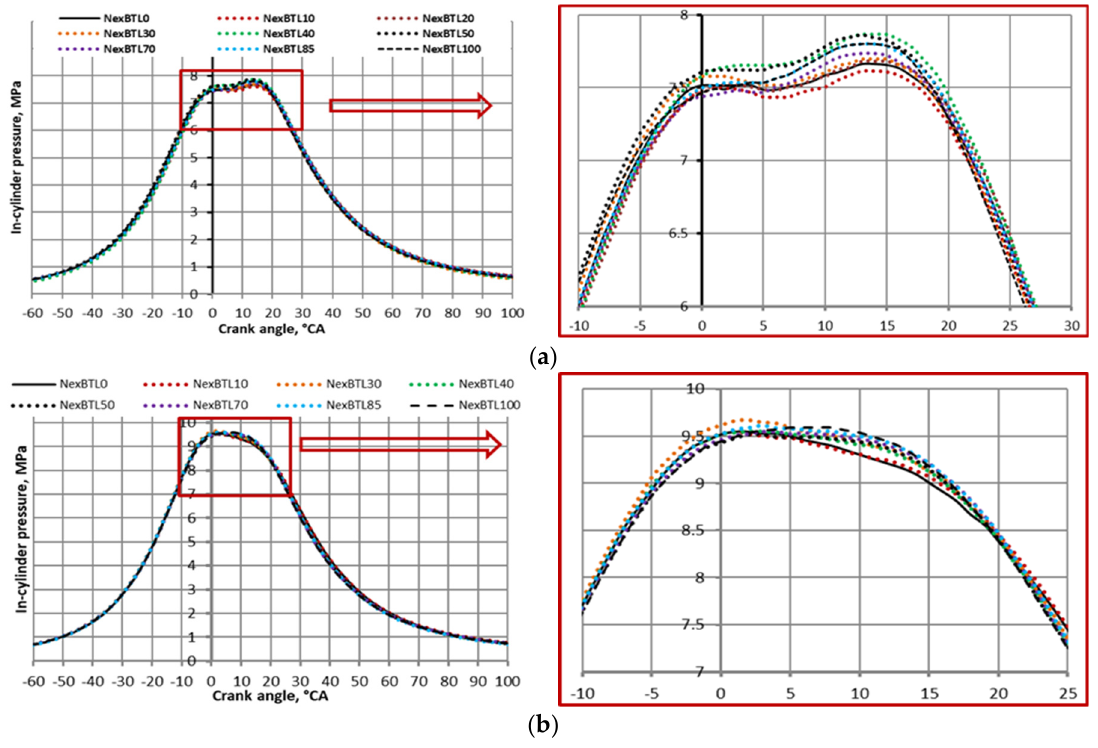
Figure 6. In-cylinder pressure characteristics: ( a ) n = 2000 rpm, M B = 120 Nm; ( b ) n = 2500 rpm, M B = 120 Nm.